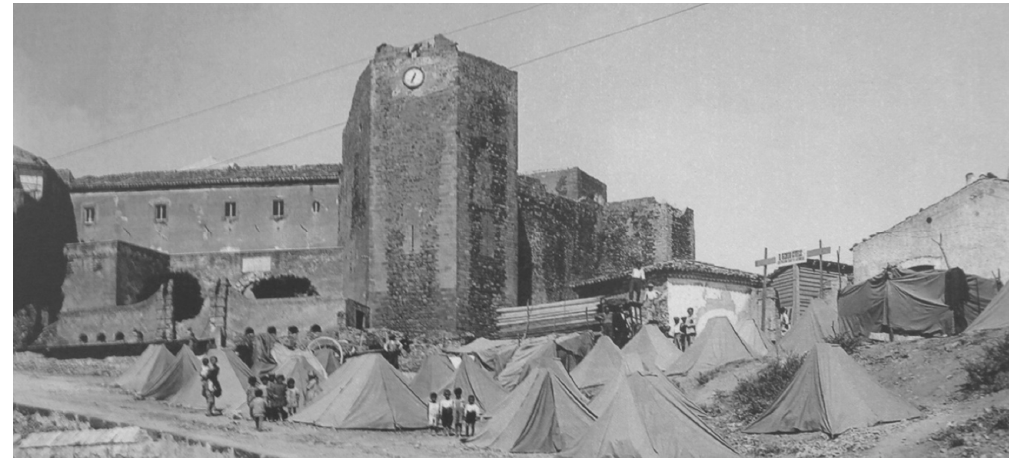
Figure 7. The Castle of Melfi after the earthquake of 23 July 1930.